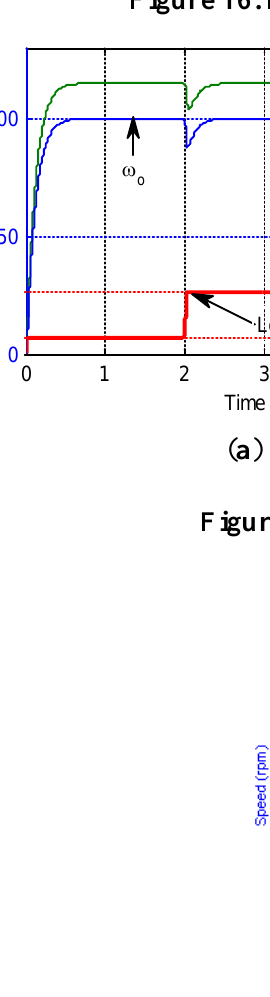
Figure 16. PDD responses under SFBK. ( a ) Simulated; ( b ) Measured.